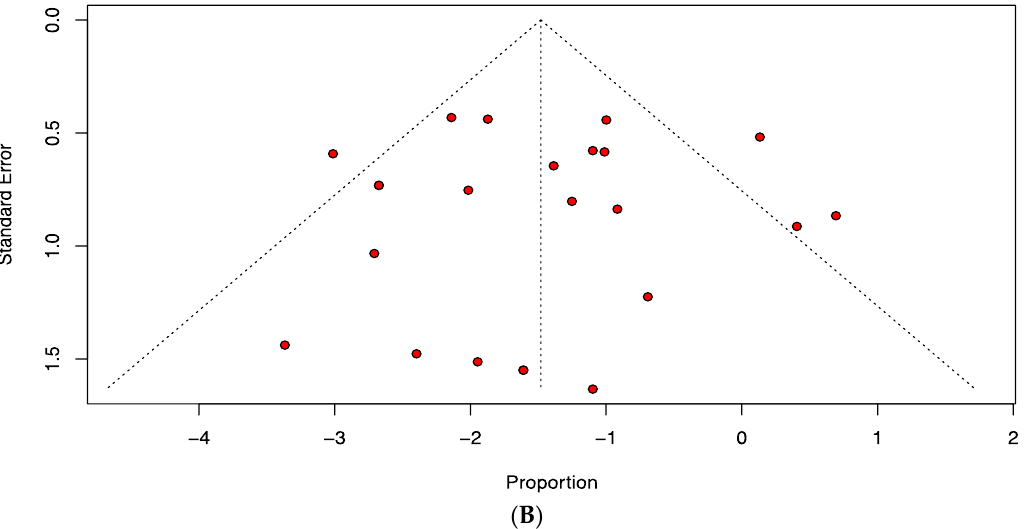
Figure 4. Funnel plots representing publication bias in relation to the prevalence of avascular necrosis following ( A ) closed pinning and ( B ) open reduction in patients with unstable slipped capital femoral epiphysis. ( A ) Egger’s test p = 0.102. ( B ) Egger’s test p = 0.882.